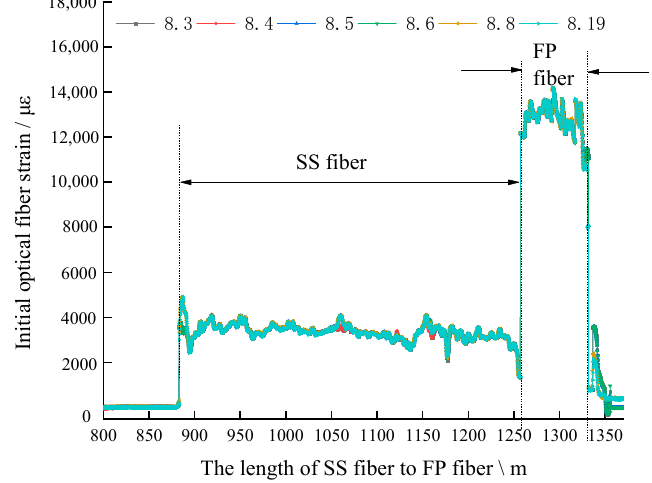
Figure 21. Original initial strain curve of optical fiber monitoring line ① .